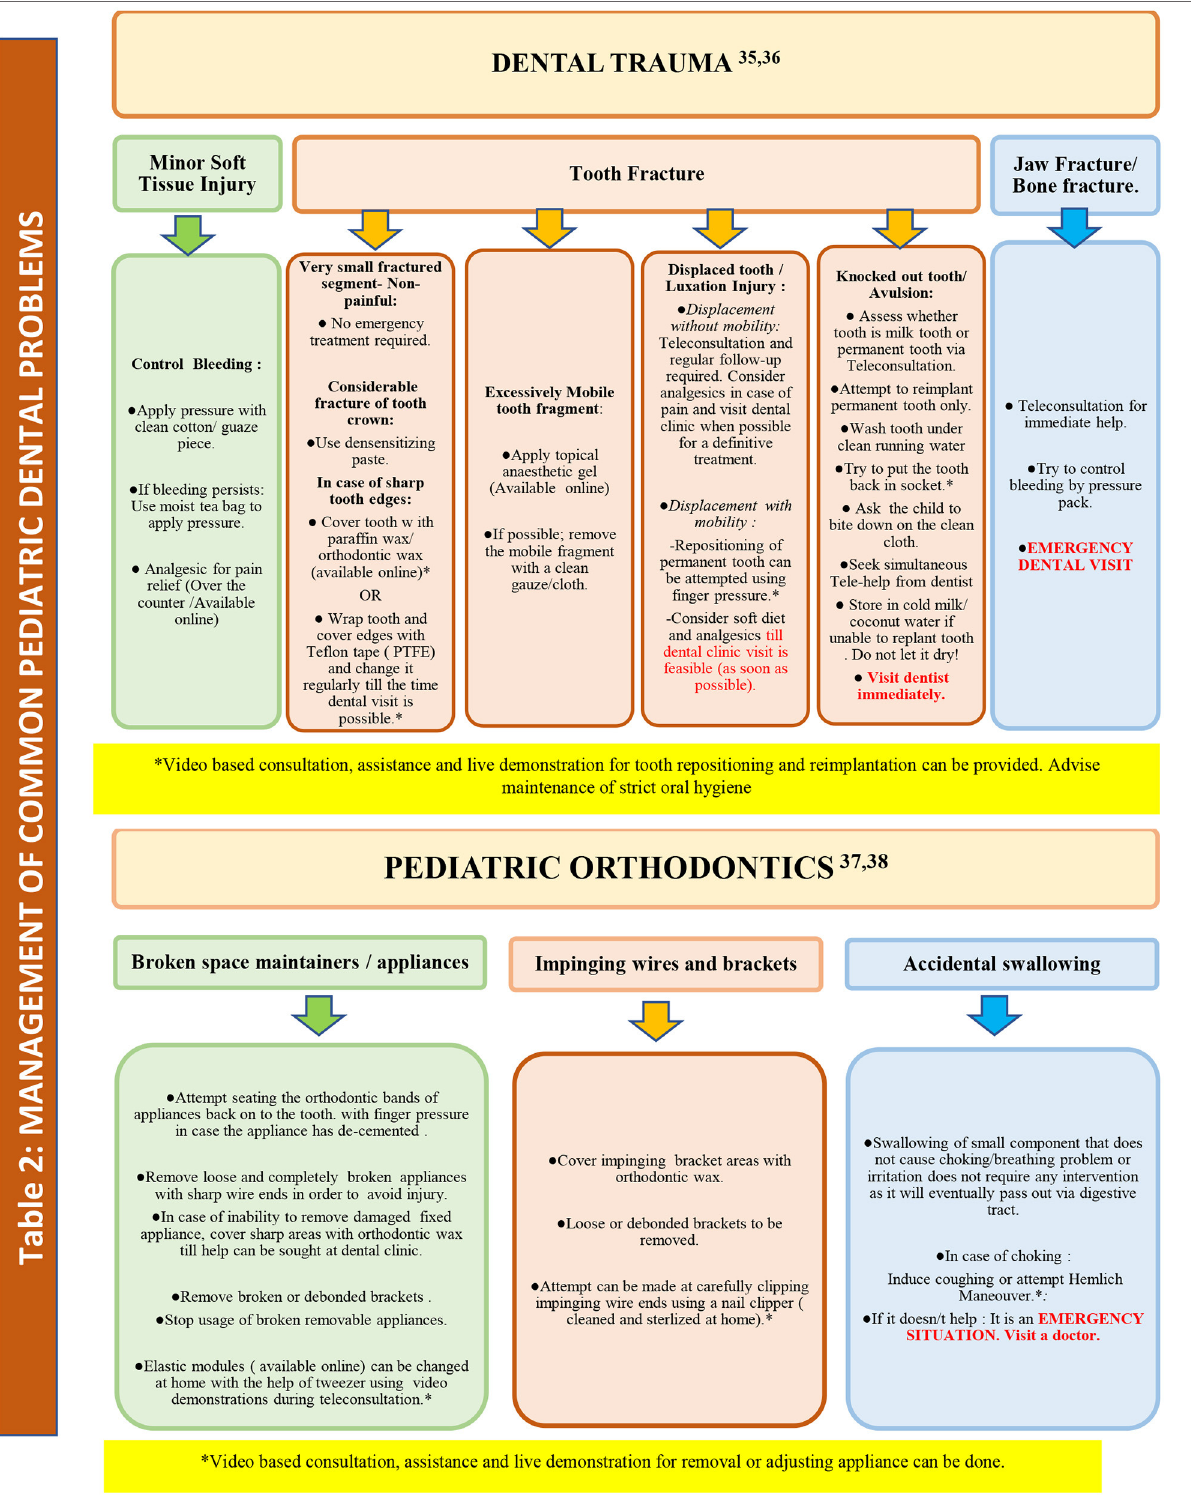
TABLE 2 | Management of common pediatric dental